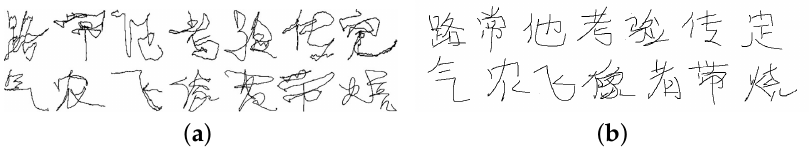
Figure 1. ( a ) In-air handwritten Chinese characters. ( b ) Traditional handwritten Chinese characters.